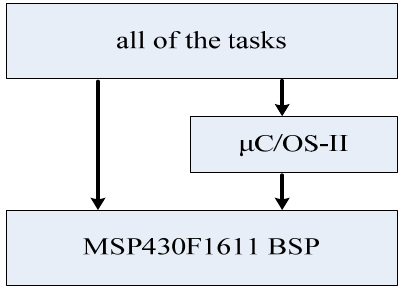
Figure 16. MSP430 module software level diagram.